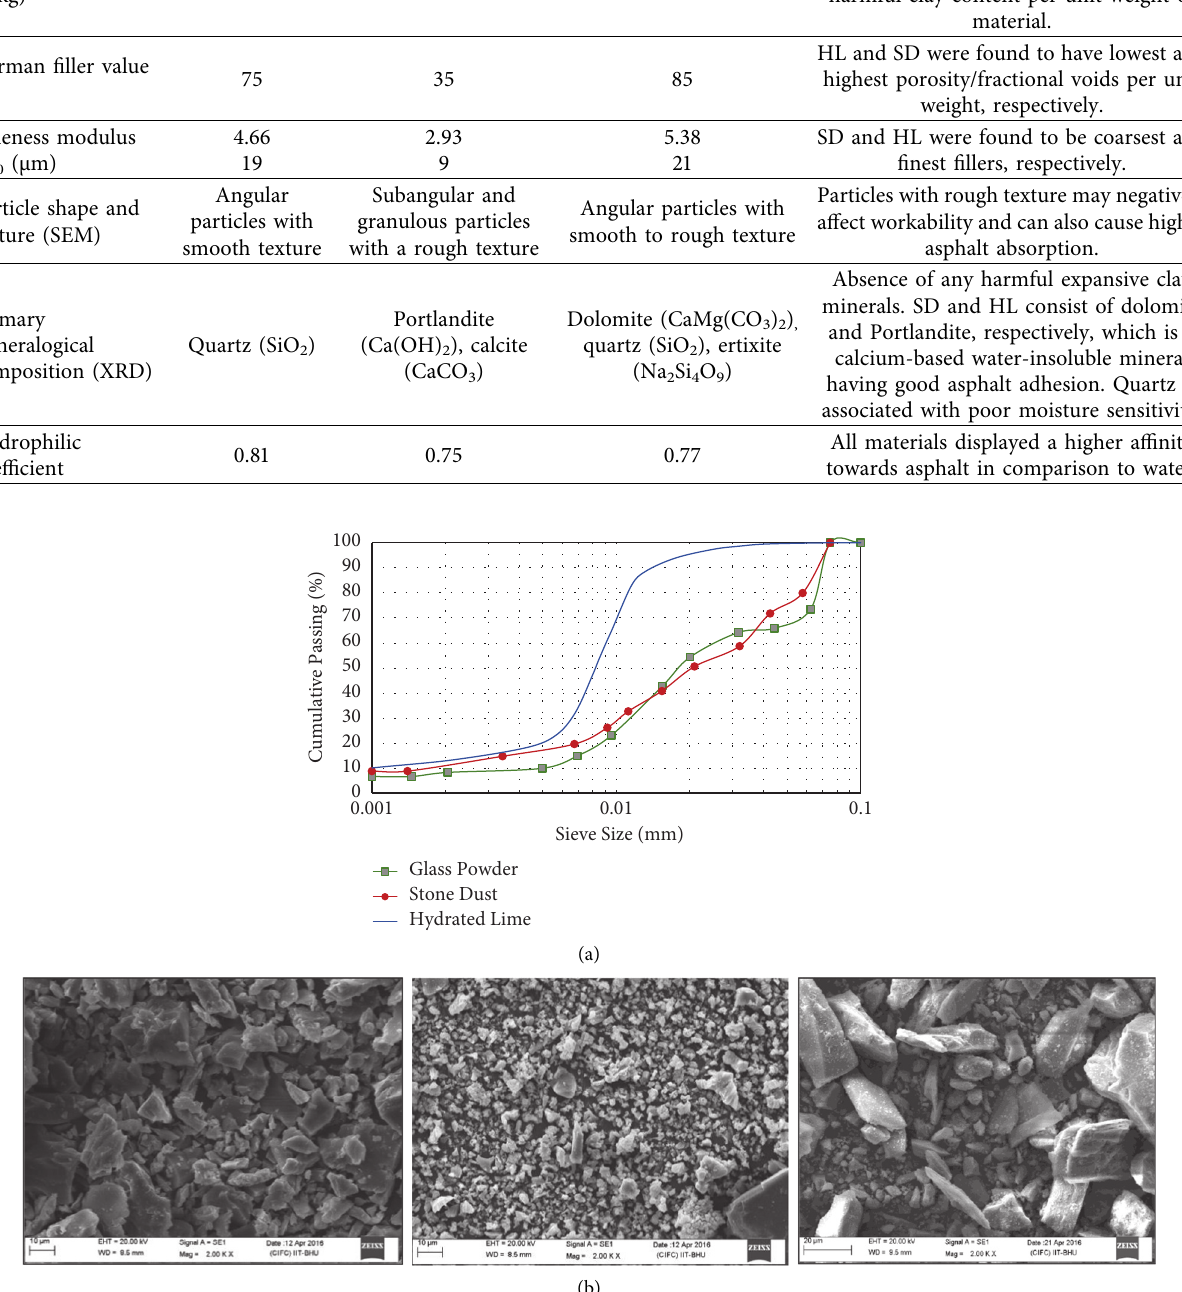
Figure 3: (a) Particle size distribution curves of various fillers. (b) SEM images of various fillers.